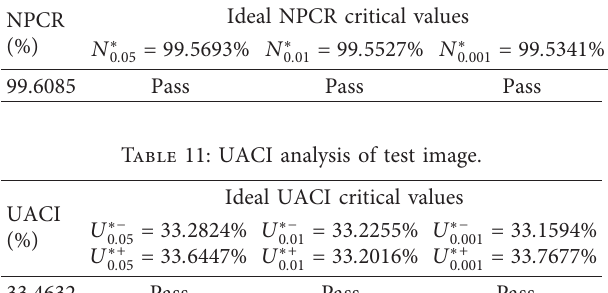
Table 10: NPCR analysis of test image.